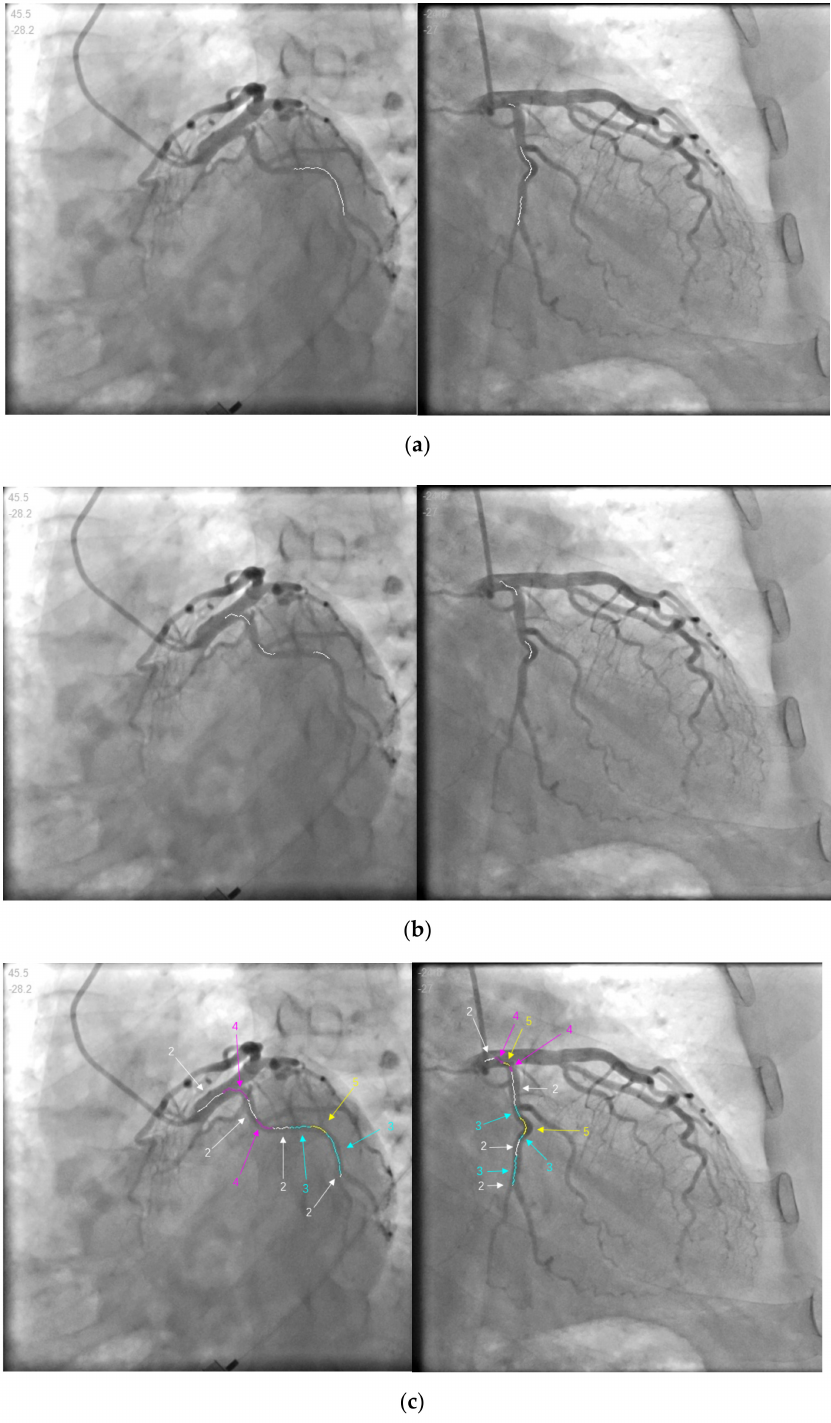
Figure 9. The CBODE of Data 1. ( a ) is the Brightness OPE; ( b ) is the Curvature OPE; ( c ) is the content of